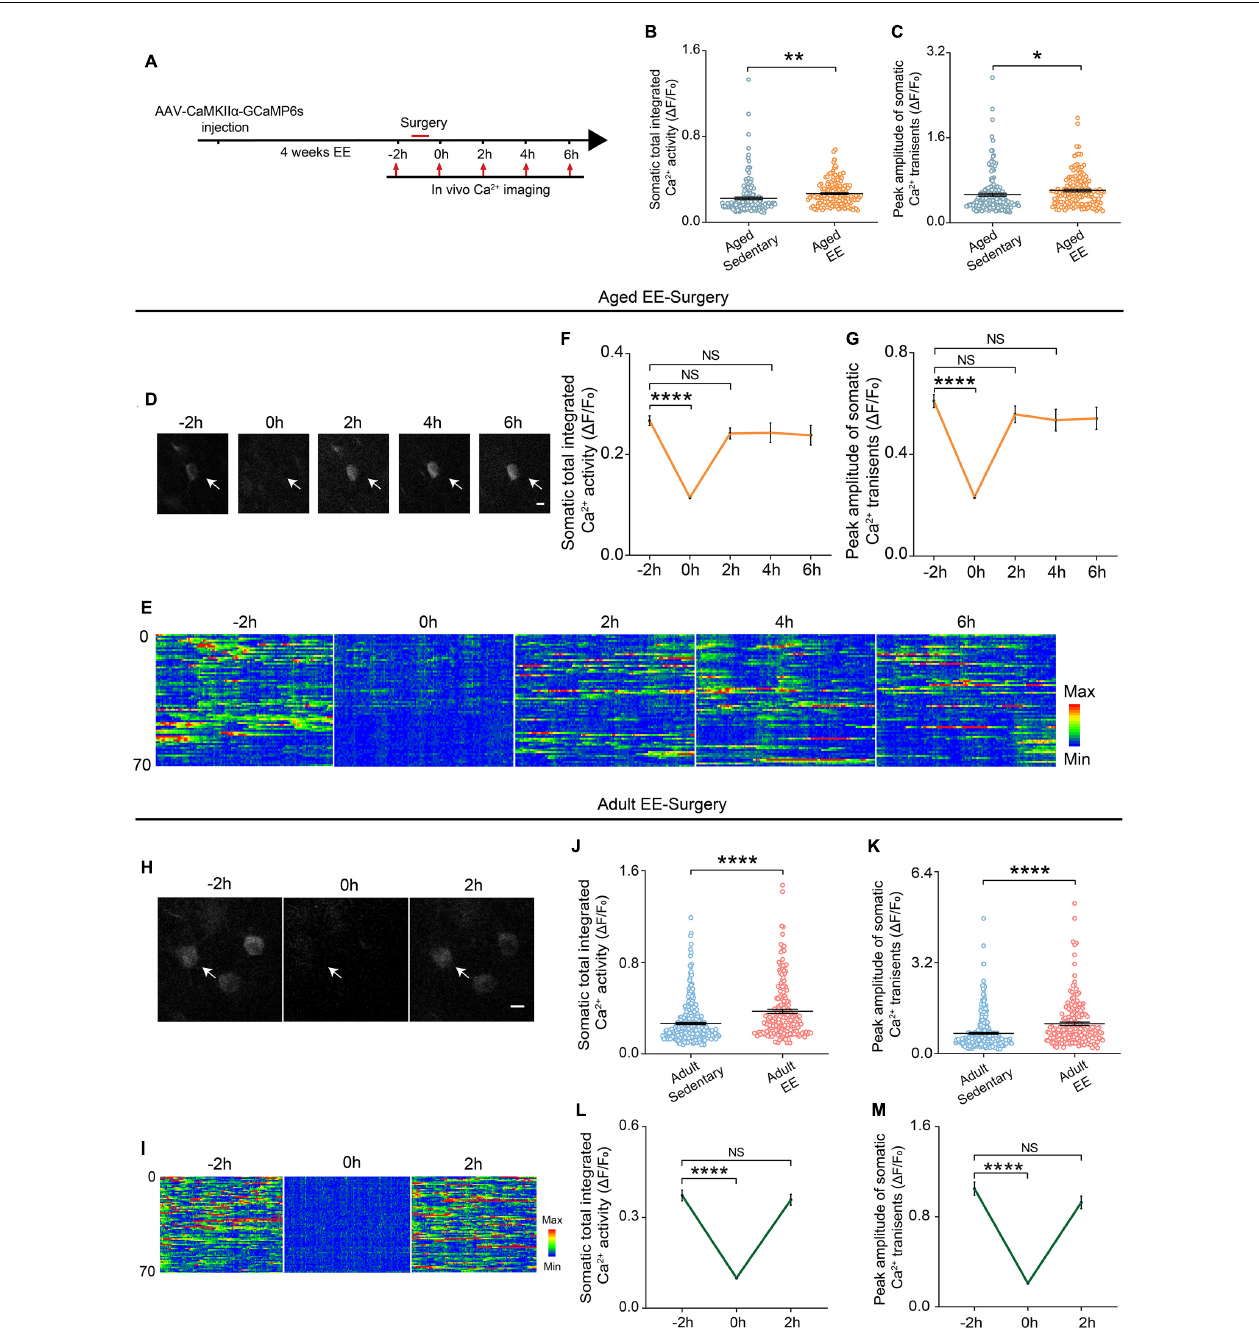
FIGURE 4 | EE prevented the prolonged reduction of neuronal Ca 2 + activity induced by surgery in the aged mice. (A) Schematic of experimental design. (B,C) Quantification of somatic total integrated Ca 2 + activity (B) and peak amplitude of somatic Ca 2 + transients (C) ( n = 169 cells from 5 mice for aged sedentary group from Figure 2 , n = 149 cells from 4 mice for aged EE group). (D) Representative images of layer V pyramidal neurons expressing GCaMP6s in aged EE-Surgery mice. Scale bars: 10 µ m. (E) Heatmaps of somatic Ca 2 + activity of the aged EE-Surgery mice at different time points ( n = 70 cells in each group). (F,G) Time course of changes in somatic total integrated Ca 2 + activity (F) and peak amplitude of somatic Ca 2 + transients (G) before and after surgery in aged EE-Surgery mice ( n = 149 cells from 4 mice). (H) Representative images of layer V pyramidal neurons expressing GCaMP6s in adult EE-Surgery mice. Scale bars: 10 µ m. (I) Heatmaps of somatic Ca 2 + activity of the adult EE-Surgery mice at different time points ( n = 70 cells). (J,K) Quantification of somatic total integrated Ca 2 + activity (J) and peak amplitude of somatic Ca 2 + transients (K) before surgery ( n = 323 cells from 5 mice for adult sedentary group from Figure 2 , n = 193 cells from 5 mice for adult EE group). (L,M) Time course of changes in somatic total integrated Ca 2 + activity (L) and peak amplitude of somatic Ca 2 + transients (M) before and after surgery in adult EE-Surgery mice ( n = 193 cells from 5 mice). Data was presented as mean ± SEM. NS stands for No Significant. Data was analyzed by One-way ANOVA followed by Tukey’s post hoc tests. *P < 0.05, **P < 0.01, ****P <